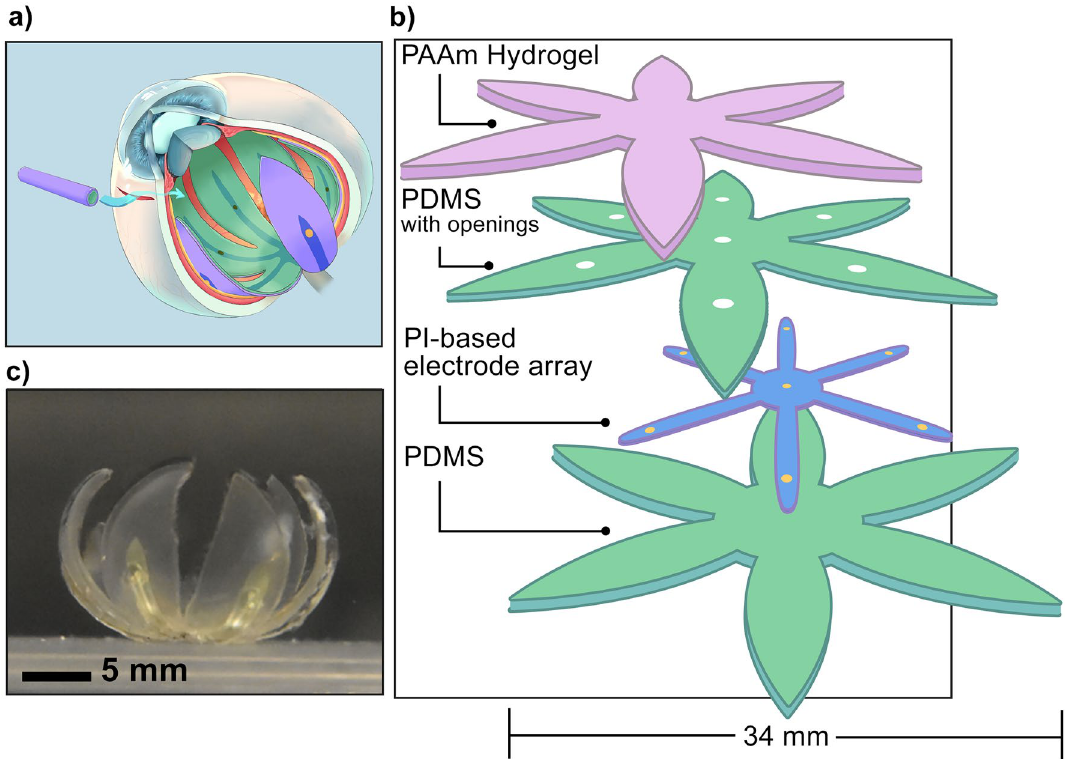
Figure 1. ( a ) Illustration of implanting the compact FFA into the eye. FFA unfolds with a fully swollen hydrogel layer. Notably, the illustrated metal electrodes were only an indication of the location of the electrodes, and the electrodes were opened on the same side as the hydrogel. ( b ) Layer-to-layer composition of the FFA. ( c ) A photo of the curved FFA placed on a supportive platform in 0.01 M phosphate-buffered saline